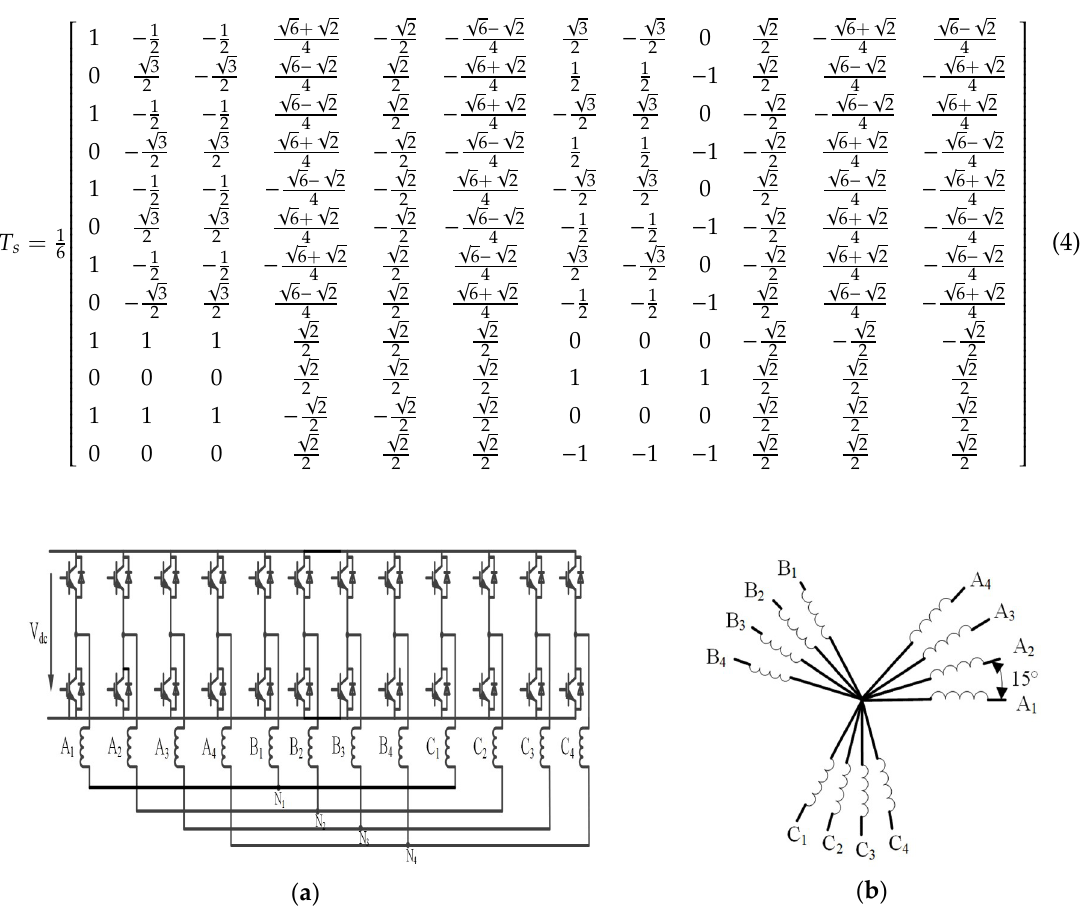
Figure 1. Twelve-phase permanent magnet synchronous motor (PMSM) system: ( a ) topology structure of inverter; ( b ) winding distribution of neutral point